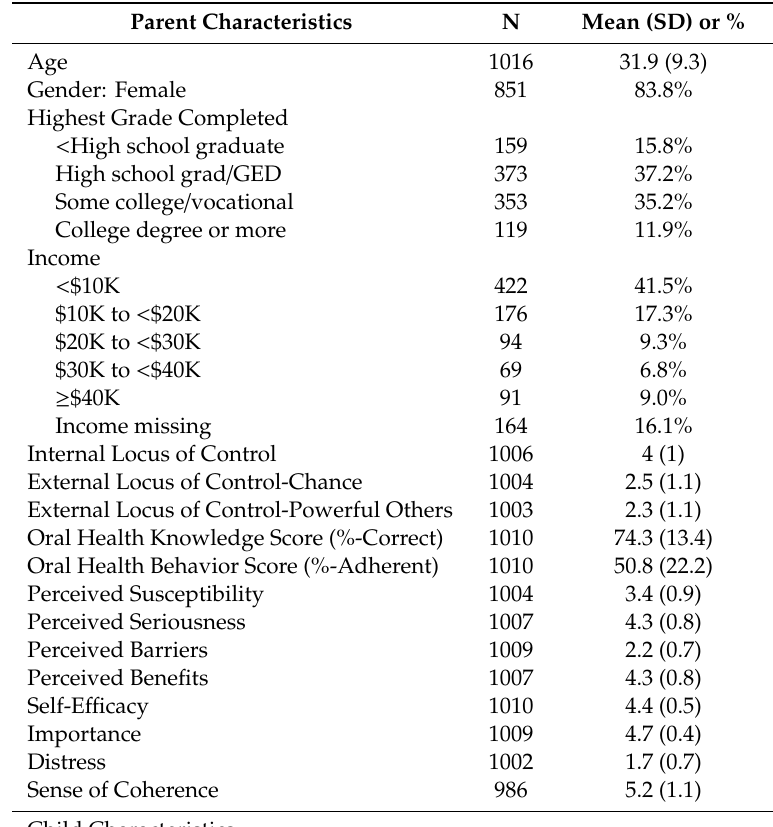
Table 2. Sample characteristics (N =